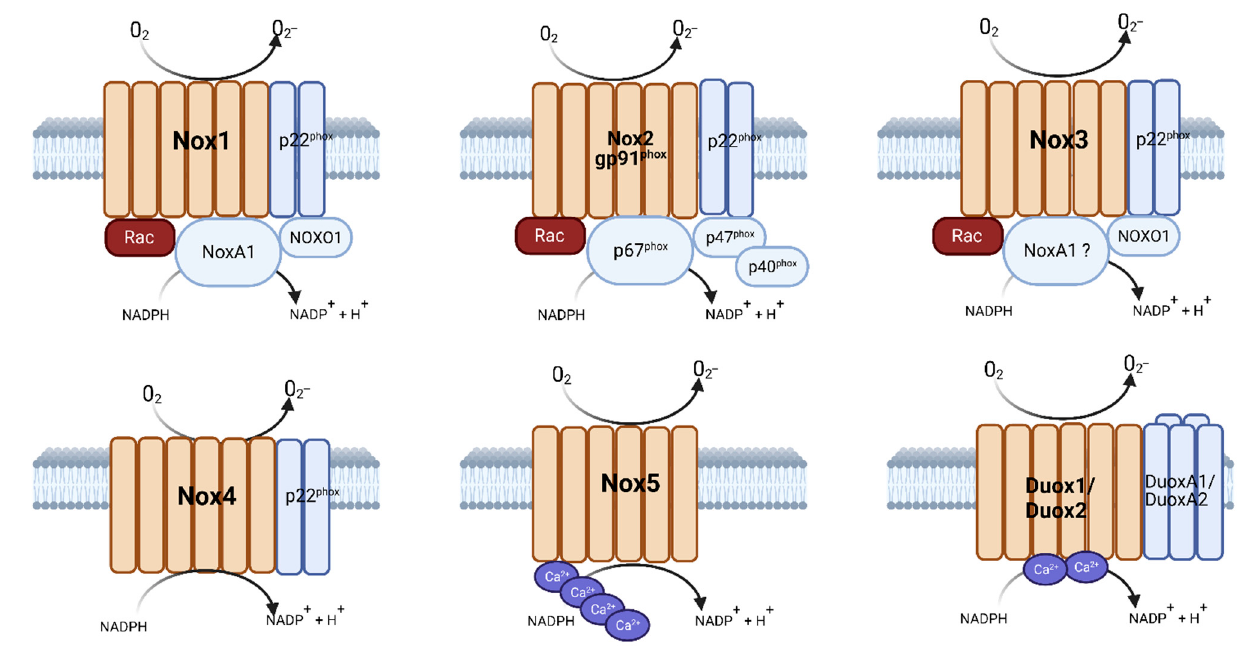
Figure 1. Structure of the Nox family members’ complexes. Created using Biorender.com and adapted from